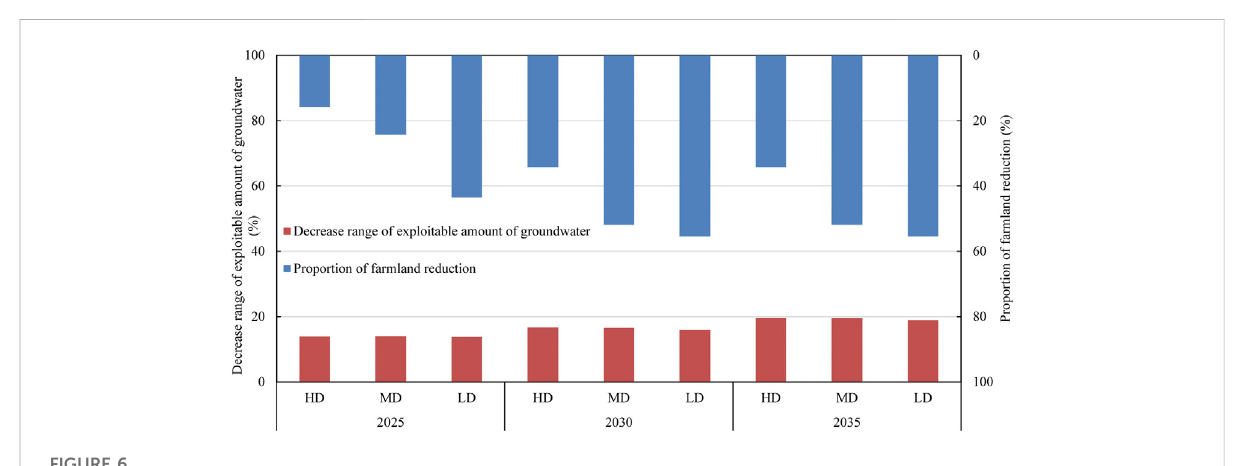
FIGURE 6 Effects on the exploitable amount of